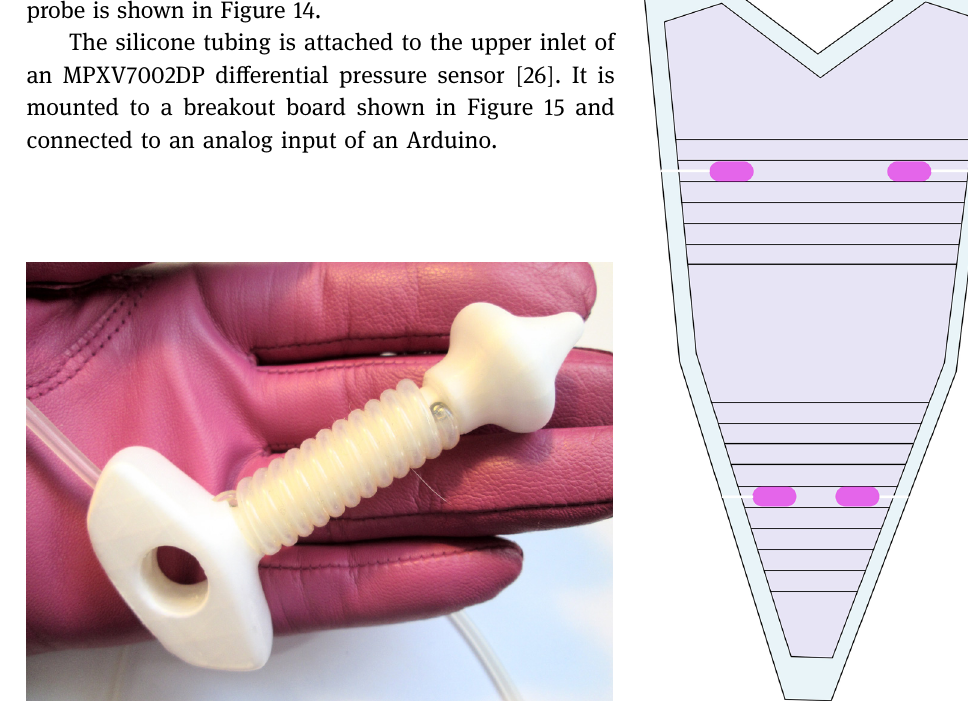
Figure 16: Bodysuit front pattern with pink bullet